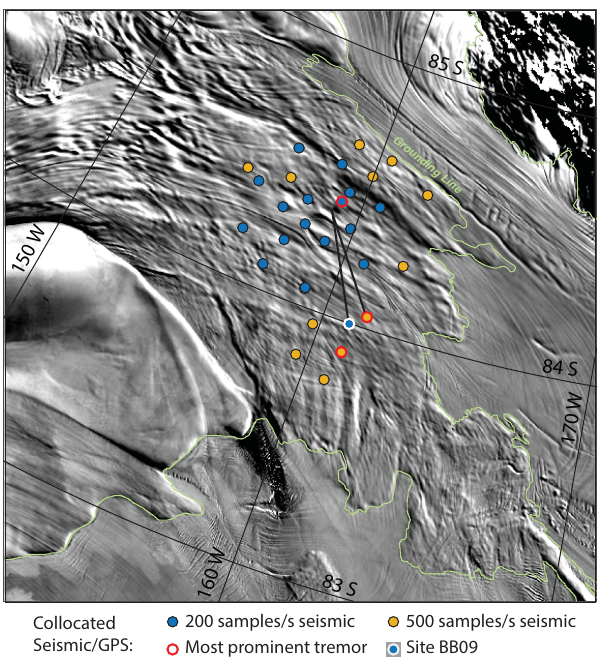
Figure 1. Map of the Whillans Ice Plain (WIP) and surrounding area. The dots show the collocated seismometer-GPS deployments used in this study. The yellow dots indicate the locations of seis- mometers recording at 500Hz, the blue dots indicate the locations of seismometers recording at 200Hz, the white outline around a dot shows the location of the station BB09, and the red outline shows the location of the seismometers that most clearly record the tremor signal. The grounding line is shown in green. The grayscale back- ground is from the MODIS composite image of Antarctica (Scam- bos et al., 2007; Haran et al.,